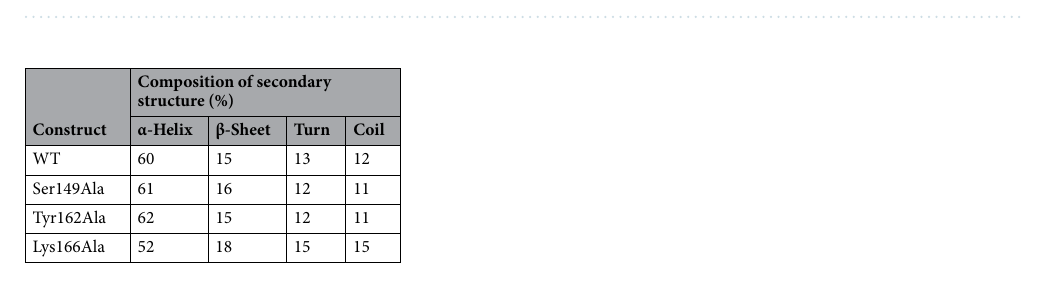
Figure 6. Analyses of purified BPSS2242 WT and mutants. ( A ) Comparison of diacetyl reductase activity. Negative control is the reaction without enzyme. Structural analysis by ( B ) CD and ( C ) intrinsic fluorescence. ( D ) Thermal stability analysis.